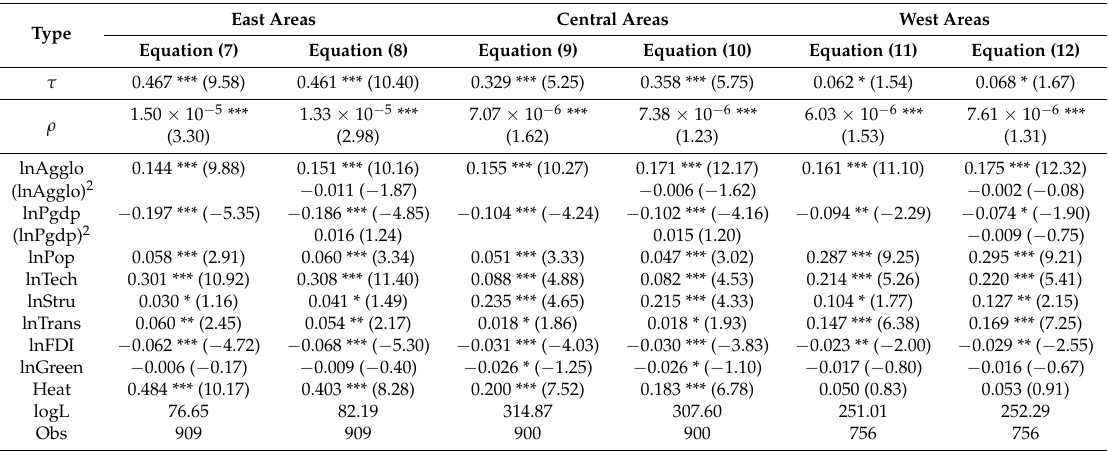
Table 4. Sub-regional test